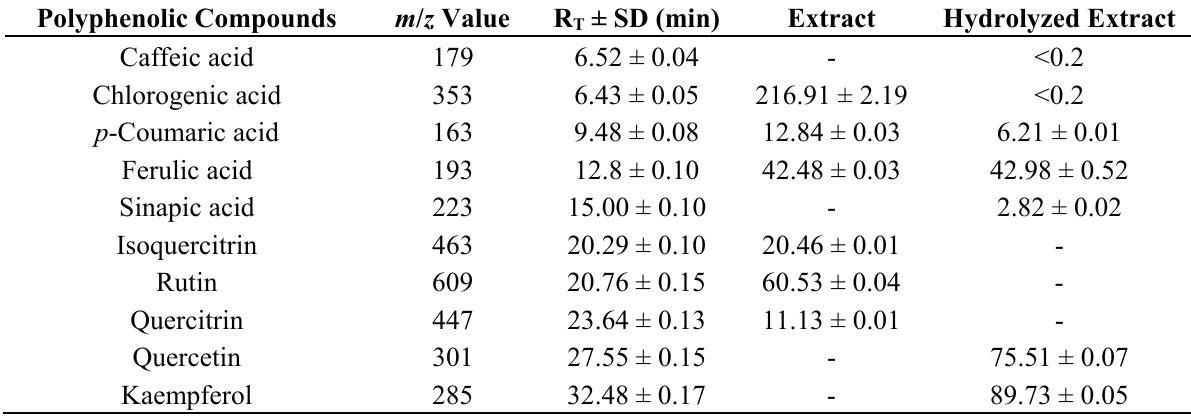
Table 1. The polyphenolic compounds content in Lycium barbarum flower extracts ( μ g/g fresh matter). Polyphenolic